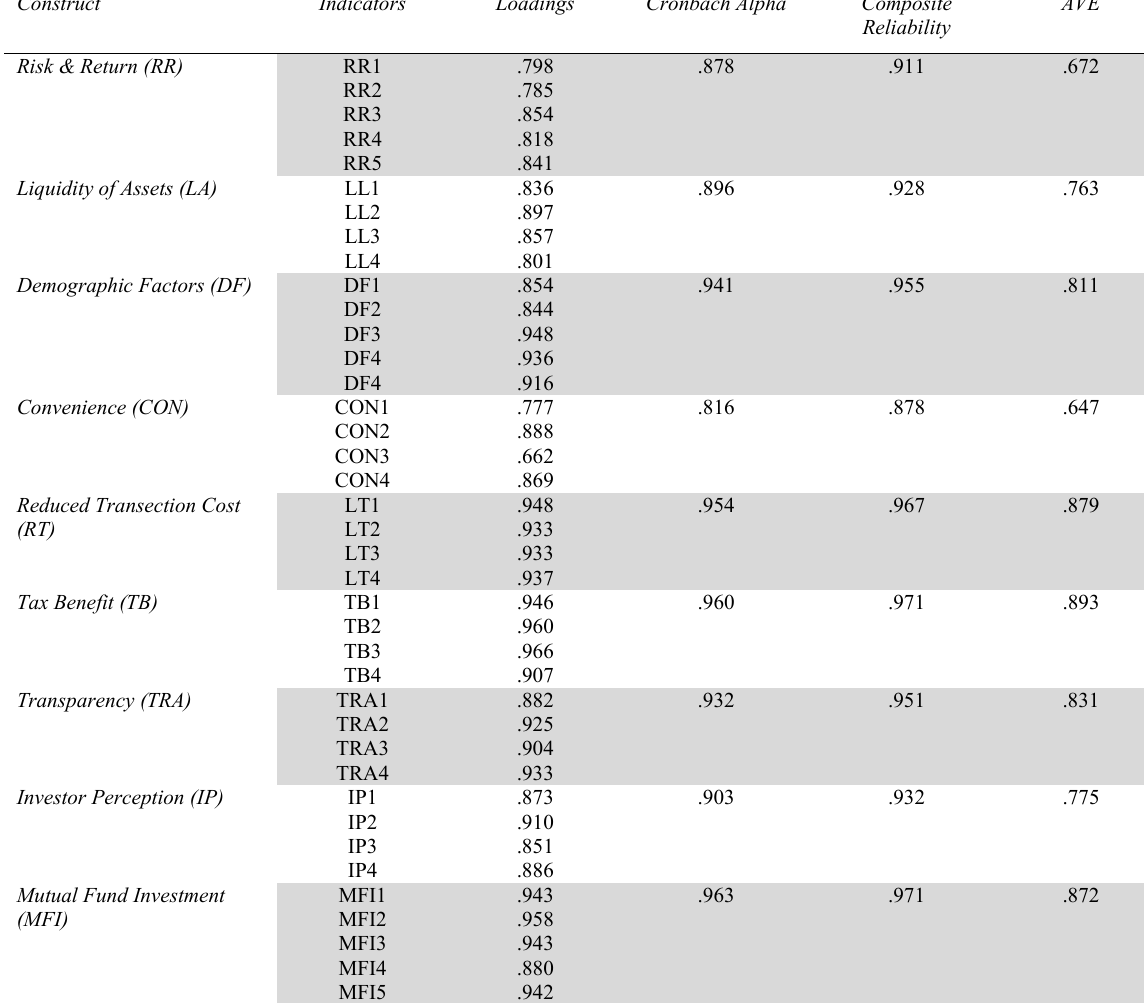
Factor Loading, Cronbach Alpha, Composite Reliability, AVE.